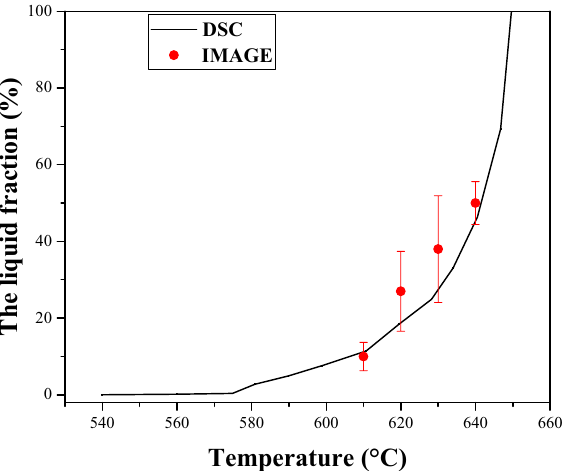
Figure 11. The liquid fractions of Al–Fe–Cu alloy by DSC and by Graphic observation for 30 min. (adapted from Ref. 2